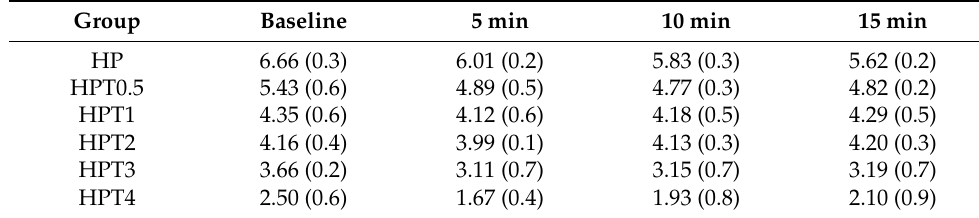
Table 2. Mean and standard deviation (SD) of pH measurement.